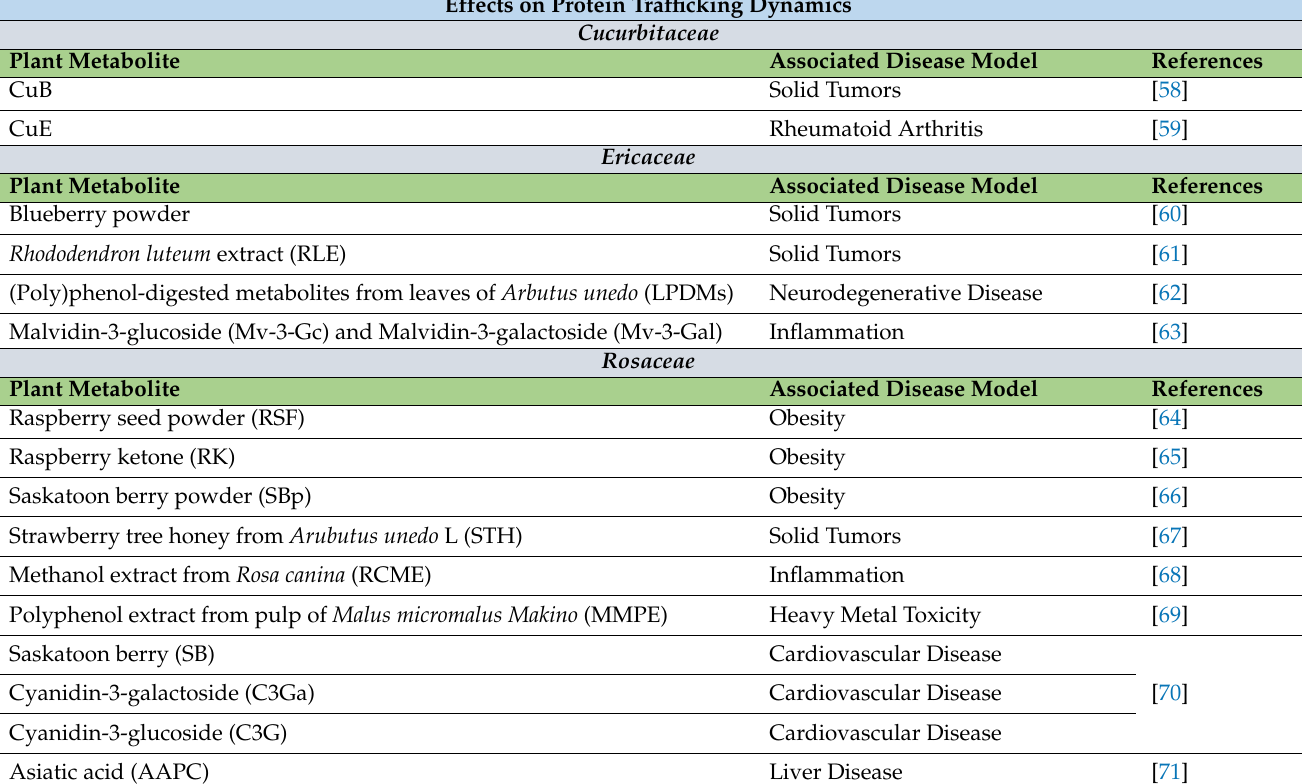
Table 5. Summary of Effects on the Protein Trafficking Dynamics across the three plant families.